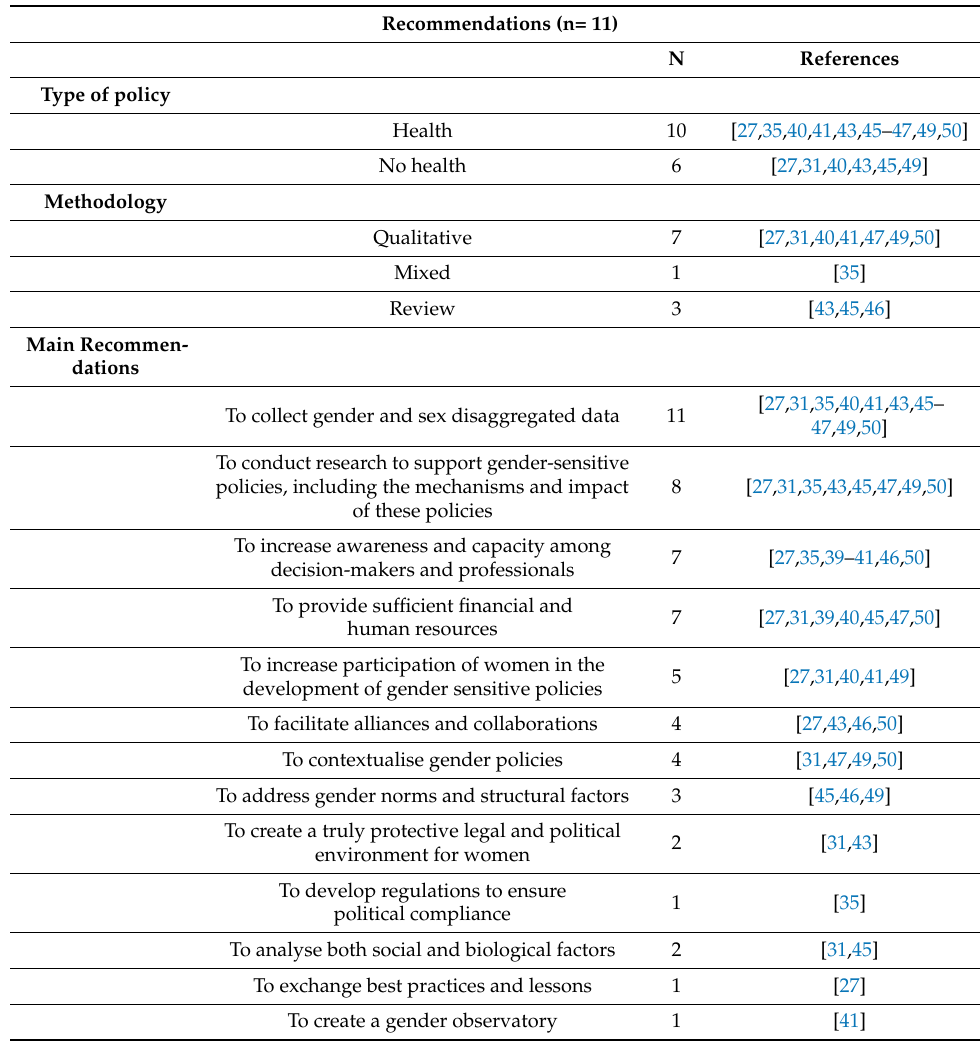
Table 4. Policy recommendations to reduce gender based health inequalities identified in the articles